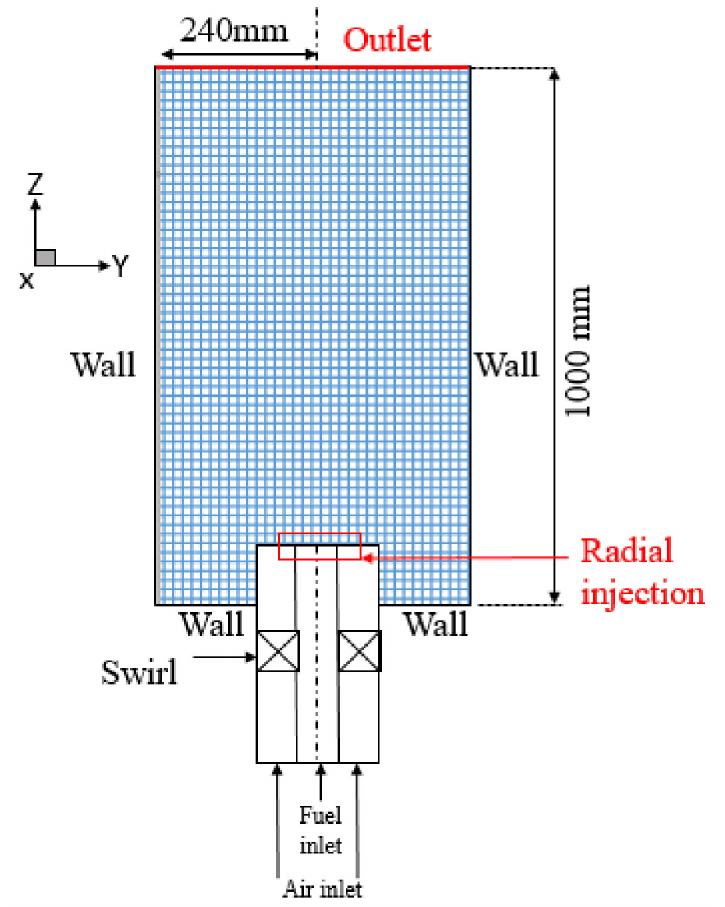
Figure 2. Computational